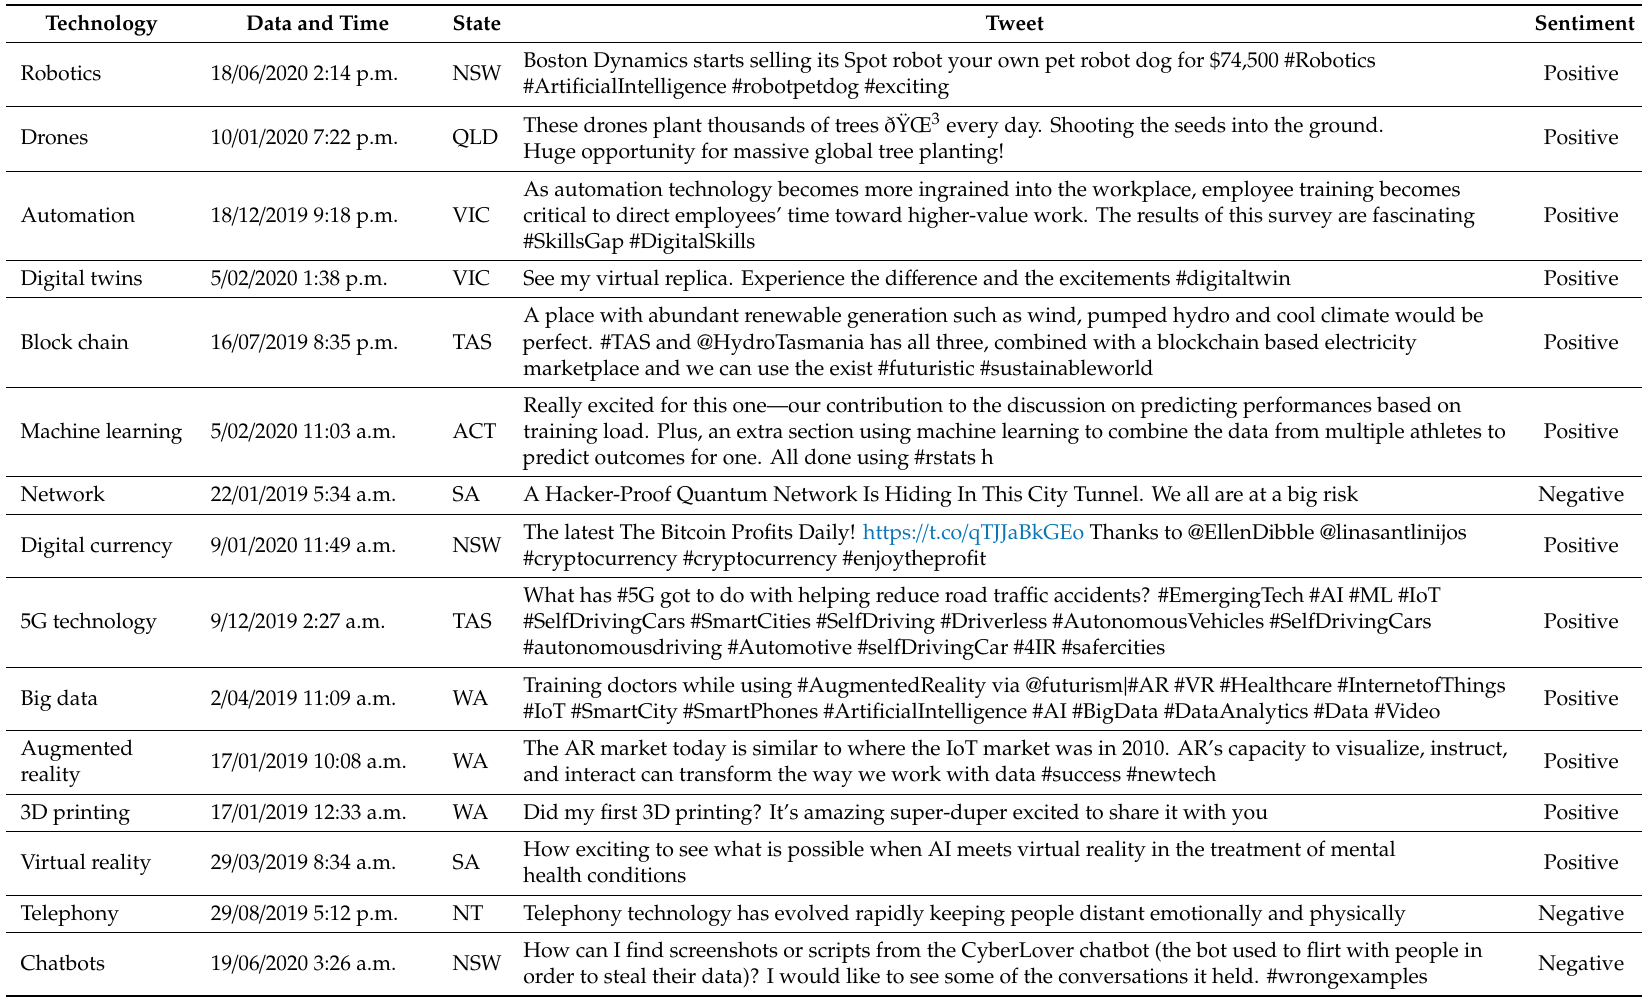
Table 4. Example tweets for AI-related